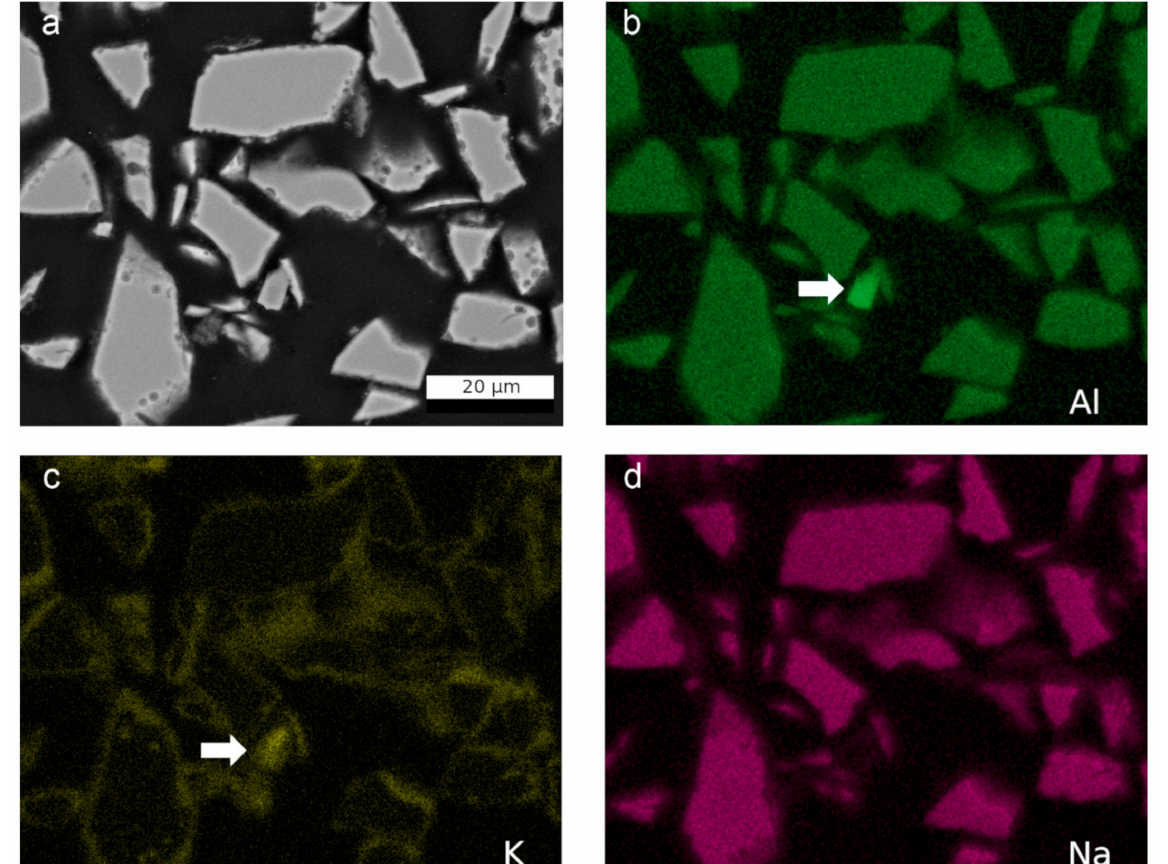
Figure 7. SEM-BSE image ( a ) and corresponding elemental mappings of Al-K lines ( b ), K-K lines ( c ), and Na-K lines ( d ) of embedded altered glass taken after 385 days in YCWCa at 70 ◦